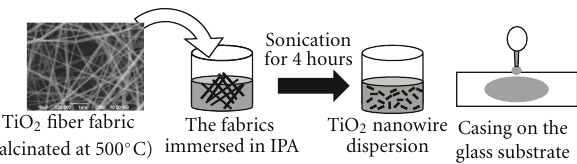
Figure 1: Schematic of preparation method of TiO 2 NW